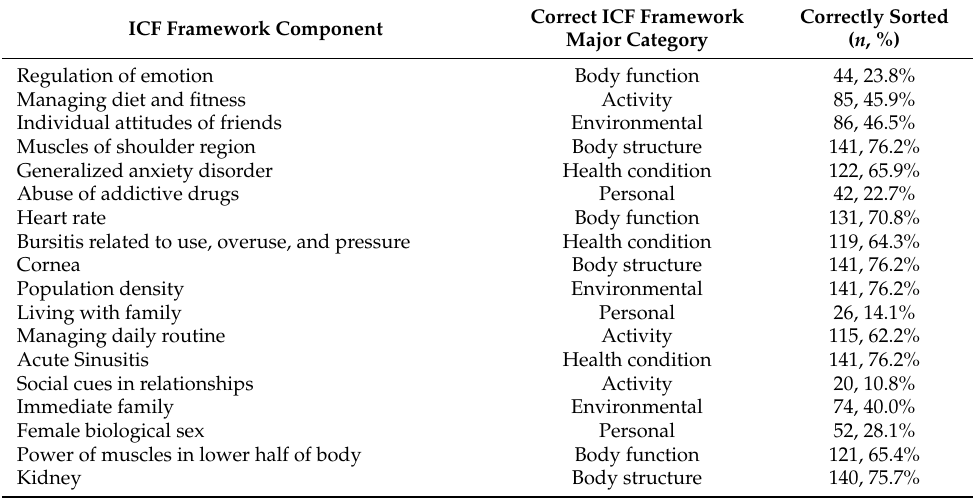
Table 4. Sorting Application Matrix of Category